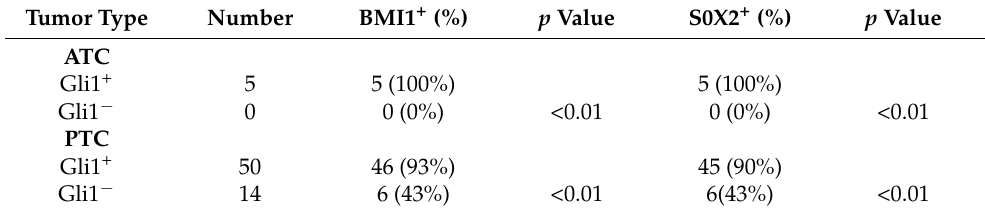
Table 3. Concomitant expression between Gli1 and BMI1 or